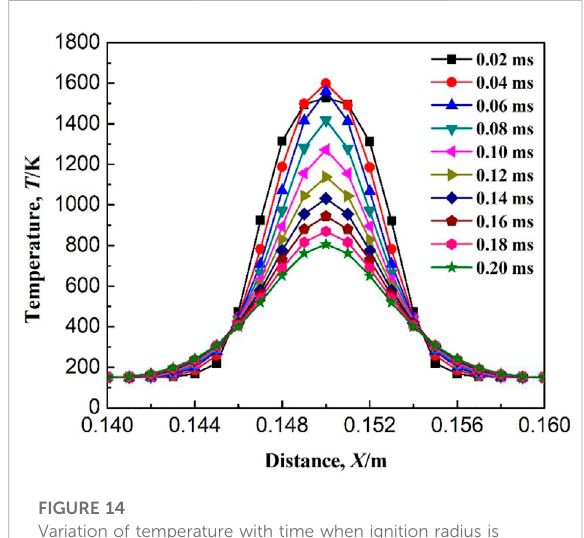
FIGURE 14 Variation of temperature with time when ignition radius is 4.5